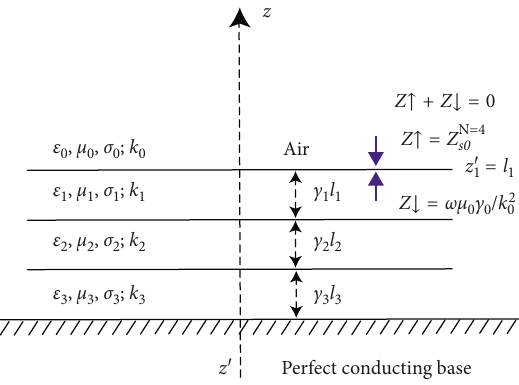
Figure 4: A five-layered model with the bottom half-space as perfectly